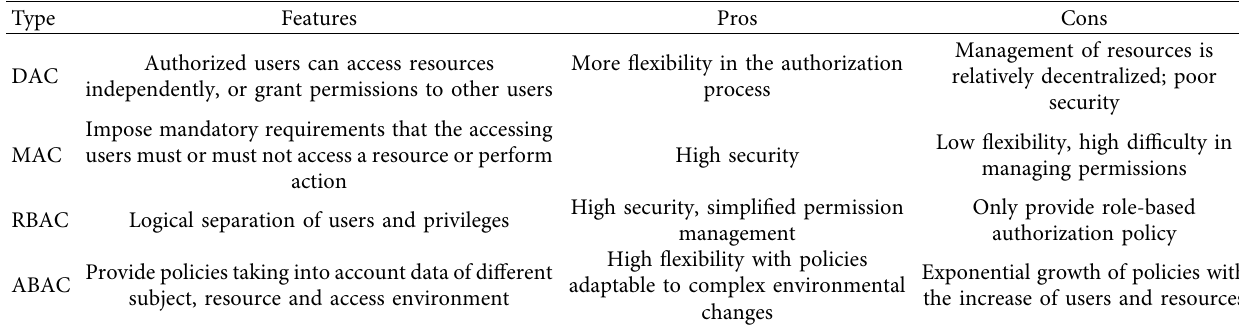
Table 1: Comparison of access control technologies in credit